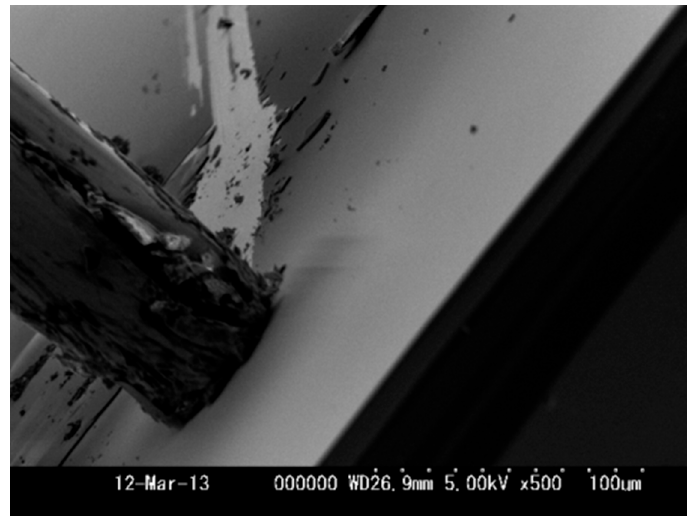
Figure 12. An SEM image for the hardness and adhesion test using a W needle.